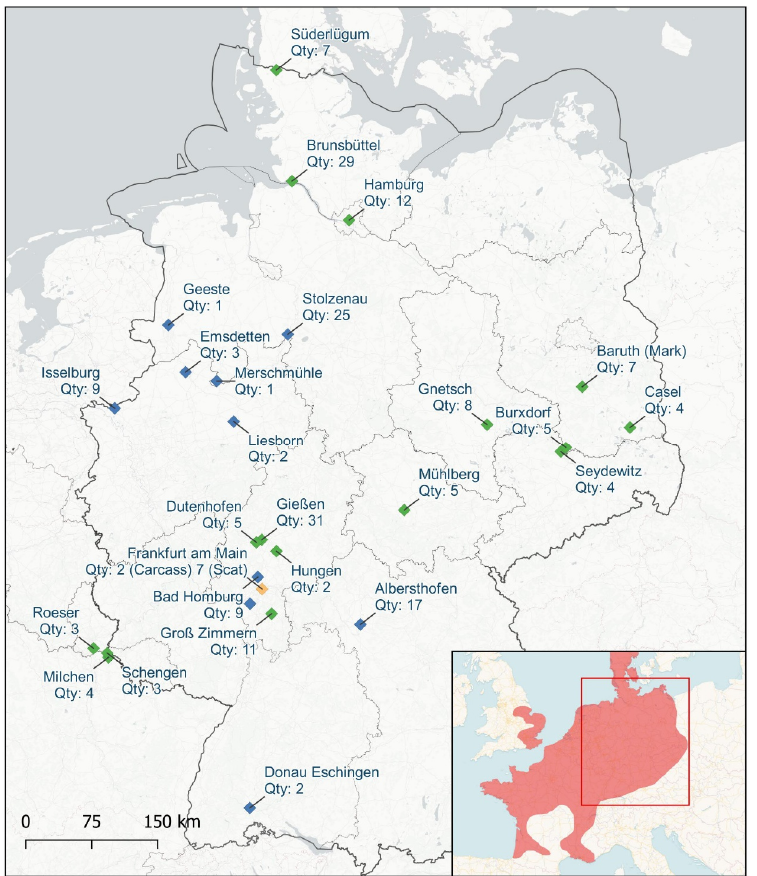
Figure 2. The map shows the origin of sampled Egyptian geese Alopochen aegyptiaca and the number of examined samples (scat samples marked in green, origin of carcasses marked in blue, places that offered both are marked in yellow) in Germany and Luxembourg. Both countries are within the non ‐ native distribution area (marked red) of the non ‐ native bird in Europe. Especially in autumn, Egyptian geese form larger flocks with up to 70 animals. These and other groups (i.e., parents with ducklings or associations of sub ‐ adults) with more individuals were regarded as a cluster. In these clusters, not every individual was sam ‐ pled but a representative number of samples were taken. To determine the representative number of samples in the specific flock, the sample size was determined following the infinite populations correction [38]. This formula determines the number of samples needed to detect a specific pathogen in a flock. All faecal samples were picked up immediately, whenever defecation was observed, to make sure that the sample could be allocated to an individual animal. After collection, the samples were fixed in 70% ethanol and stored until further investigation. Furthermore, in the current study, 114 Egyptian geese carcasses, obtained from five different Federal states of Germany, were examined by necropsy. These animals were shot by hunters during the authorised hunting seasons of the respective Federal state. This was to control the A. aegyptiaca population or to prevent bird strikes on planes, as requested